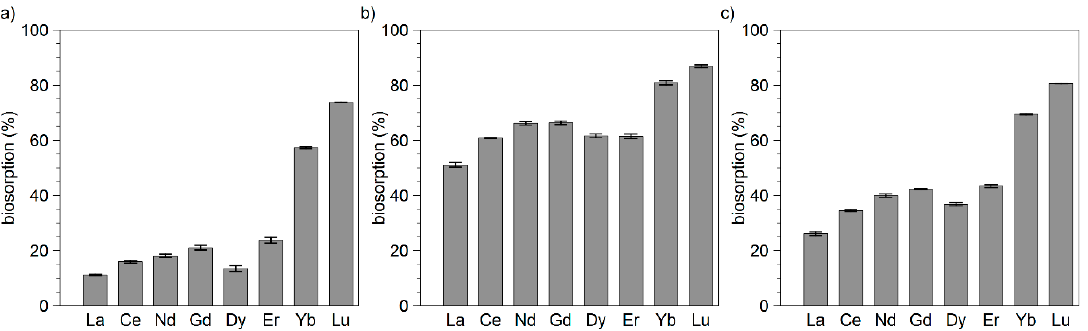
Figure 2. Biosorption of REEs by B. subtilis (( a ) gram-positive), L. methylohalidivorans (( b ) gram-negative) and P. inhibens (( c ) gram-negative). BM 5 g/L, initial REE concentration was 15 µmol/l for each element, sampling took place after 2 h. Bars show mean of two parallel assays, error bars show standard deviation.